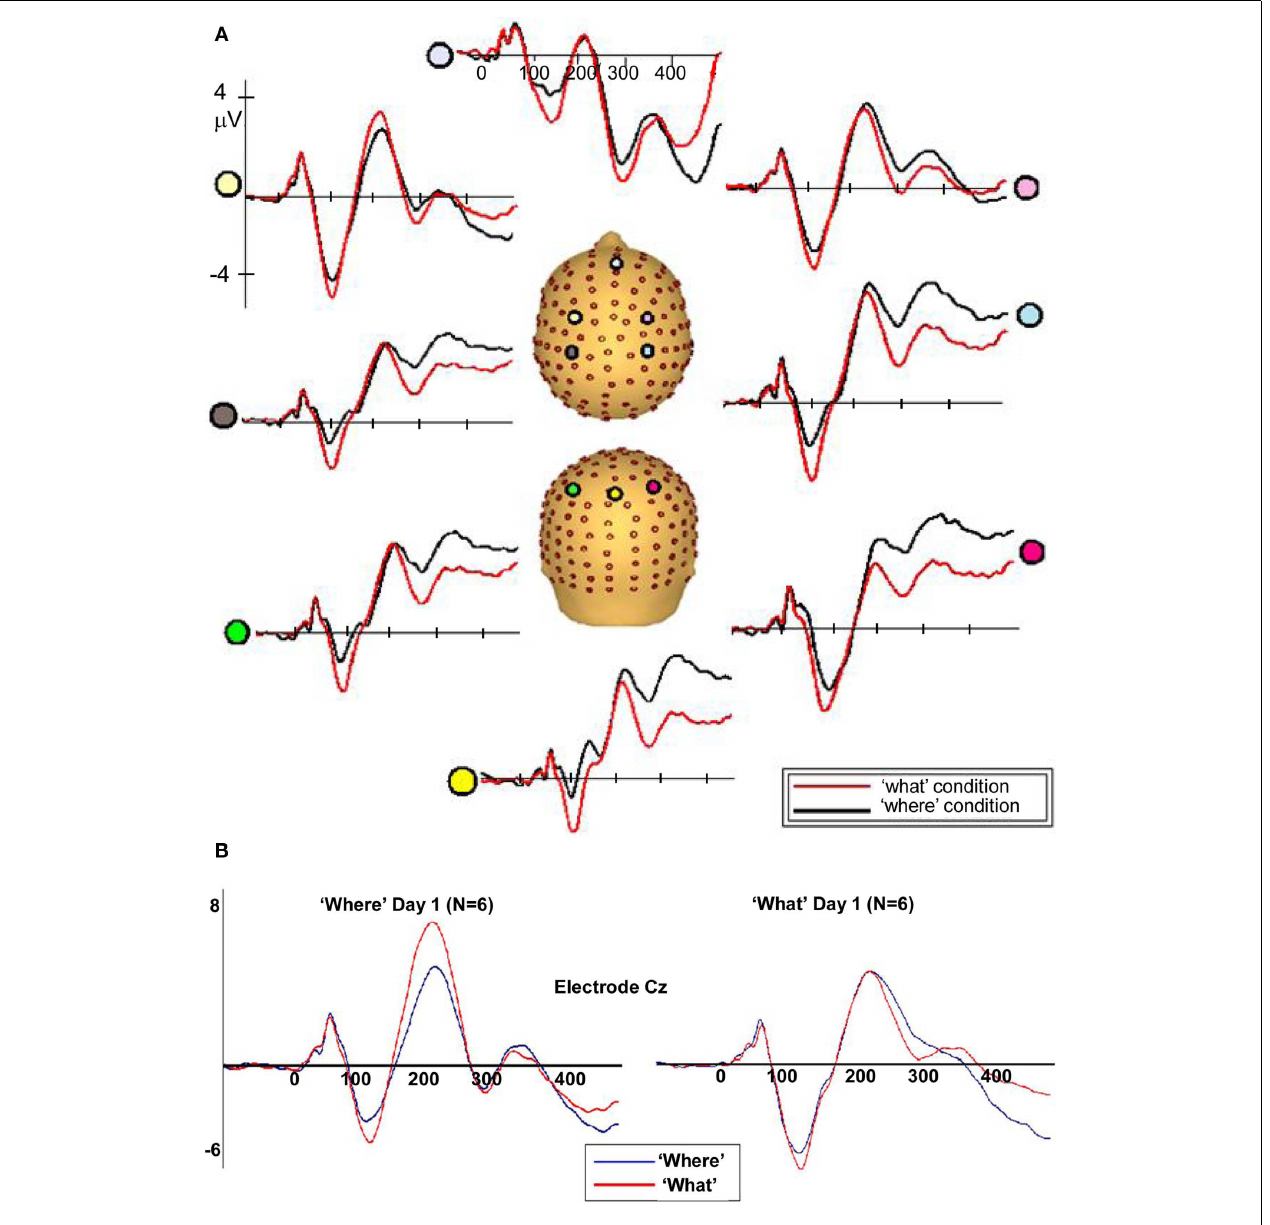
FIGURE 5 | (A) Auditory evoked potentials in participants generated during the WHAT task (red) and the WHERE task (black). Data from eight electrodes spanning frontal, central, and centro-parietal regions are presented. (B)